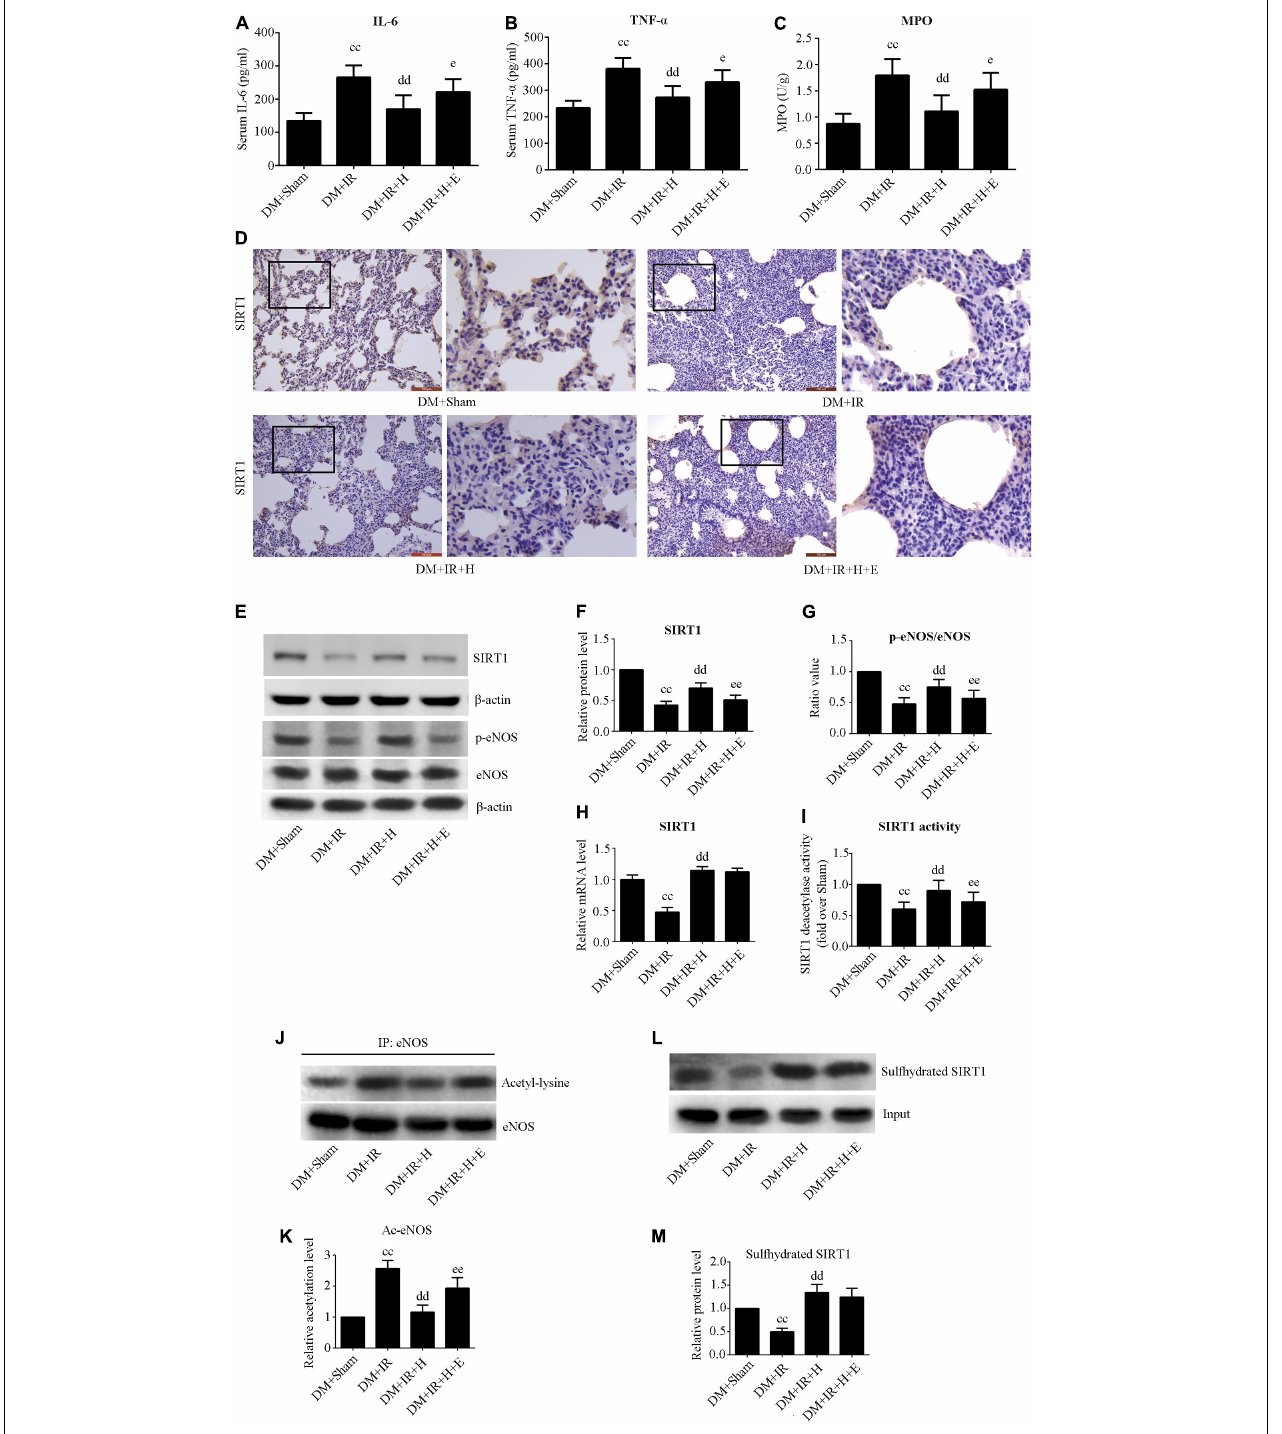
FIGURE 4 | EX527 attenuated GYY4137-induced alleviation of the inflammation in diabetic lung IR injury. (A) Serum concentrations of interleukin-6 (IL-6). (B) TNF- α . (C) MPO concentration. (D) Representative lung immunohistochemical images of SIRT1 (magnification: 200 × ). (E) Representative blots. (F) SIRT1 expression. (G) The ratio of p-eNOS/eNOS. (H) mRNA expression of SIRT1 ( n = 4). (I) Relative SIRT1 activity. (J) Representative blots. (K) Ac-eNOS. (L) Biotin switch assay. (M) Sulfhydrated SIRT1 expression. Ac-eNOS, acetylated endothelial nitric oxide synthase; eNOS, endothelial nitric oxide synthase; p-eNOS, phosphorylated endothelial nitric oxide synthase ( cc P < 0.01 versus DM + sham group, dd P < 0.01 versus DM + IR group, e P < 0.05 versus DM + IR + H group/ ee P < 0.01 versus DM + IR + H group; n = 8 in each group).